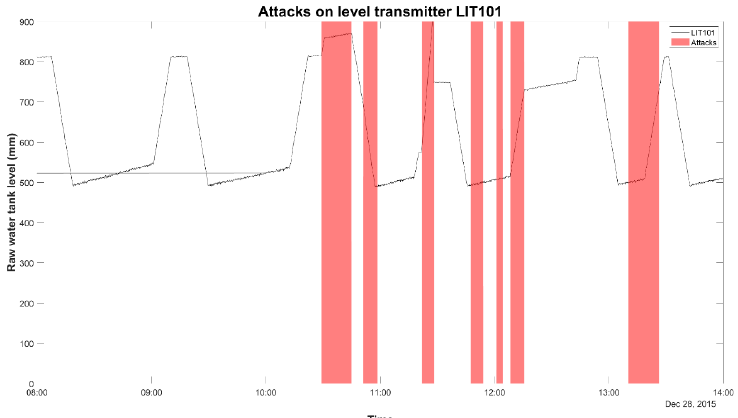
Figure 3. A tt acks on level transmi tt er. Figure 3. Attacks on level